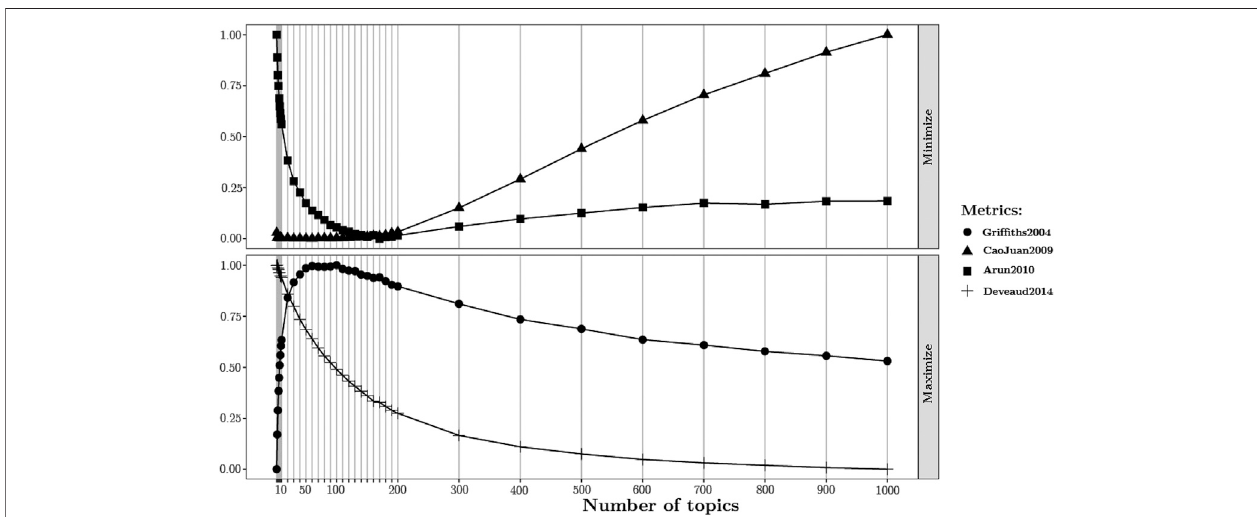
FIGURE 5 | Variation of four metrics with respect to the number of topics. On the top, Arun2010 and CaoJuan2009 metrics have to be minimized. On the bottom, Deveaud2014 and Grif fi ths2004 have to be maximized. They de fi ne a range where the correct number of topics should be